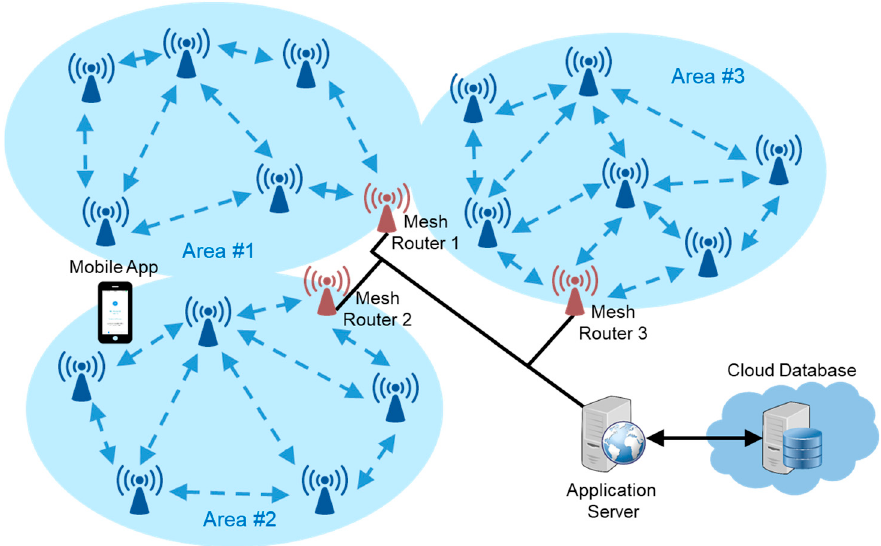
Figure 12. Deployment with multiple subareas to reduce the hop count to the Mesh Router.